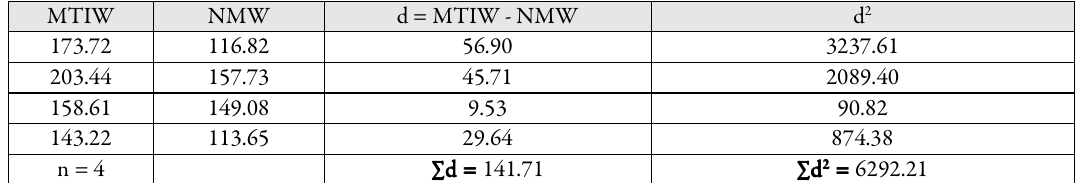
Table 2. Data used for the computation of paired t-test value